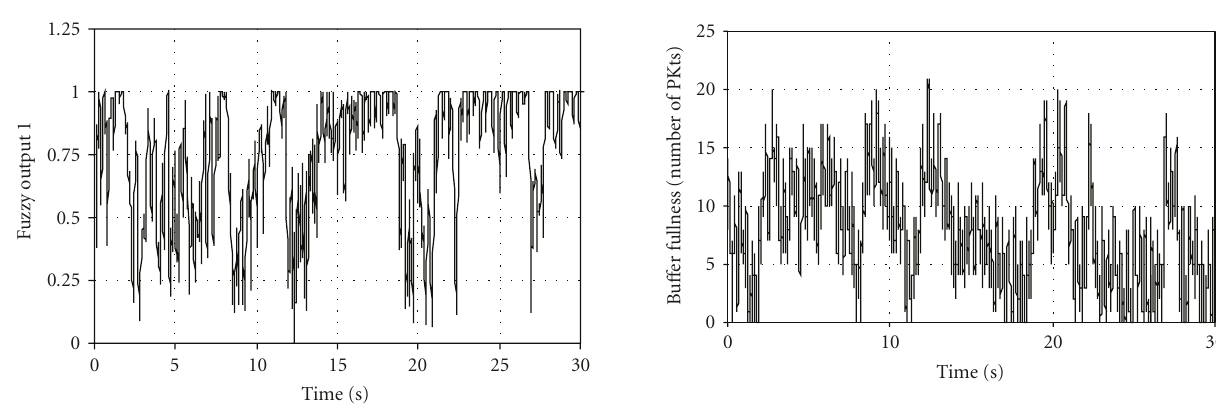
Figure 9: Bu ff er fullness input to stage one of the FLC, with a = 2.